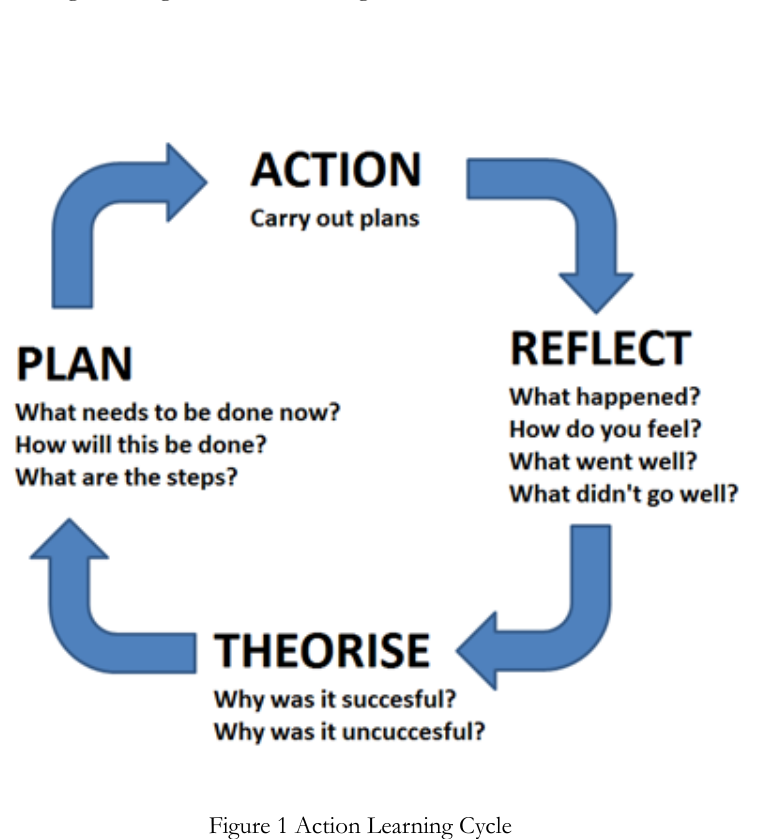
Figure 1 Action Learning